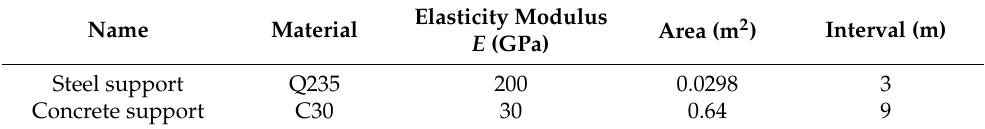
Table 3. The parameters of connectors.